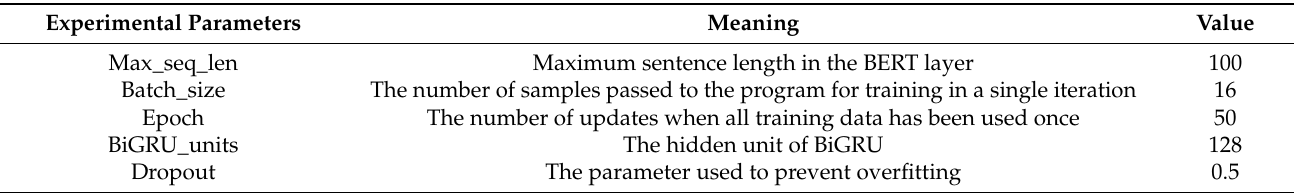
Table 3. Experiment parameters’ meaning and setting.